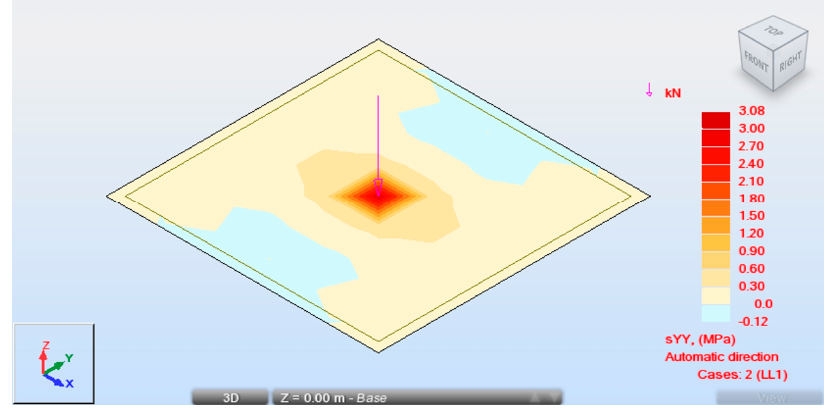
Figure 4. Plate calculation model.